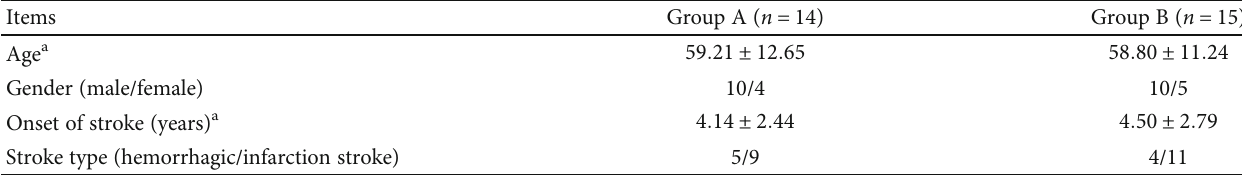
Table 1: Demographic data of the stroke patients.